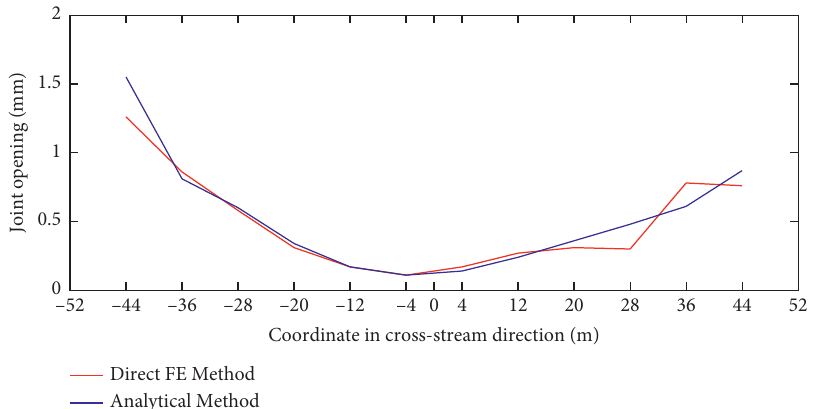
Figure 13: Maximum envelope of joint opening at the crest due to the Swedish design earthquake for foundation modelling using direct FE method and analytical method.